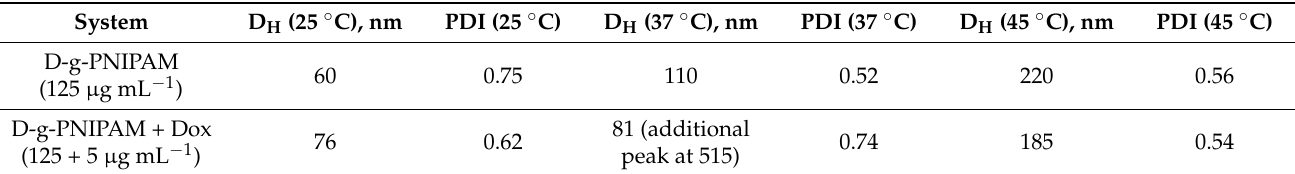
Table 2. Evaluation of size change for D-g-PNIPAM and D-g-PNIPAM + Dox particles in Hank’s solution at different temperatures.